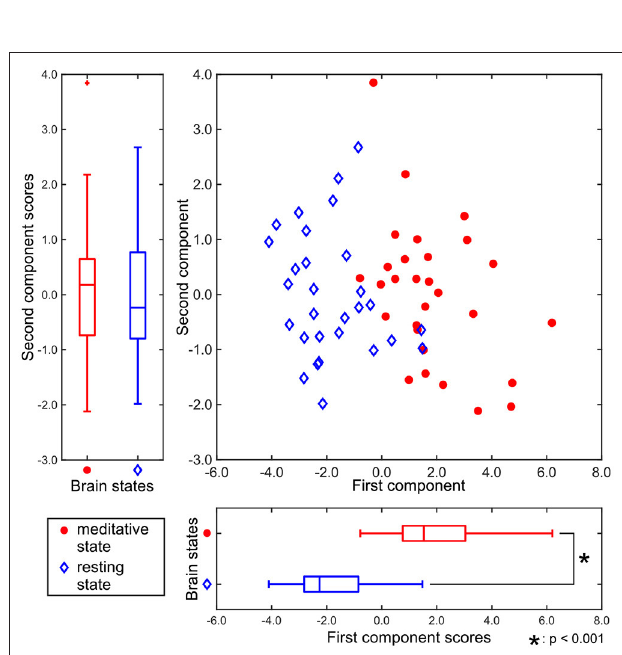
FIGURE 3 | Component scores obtained by T3Clus. Each point indicates each participant’s data. The meditative state is red-colored and the resting state is colored blue.